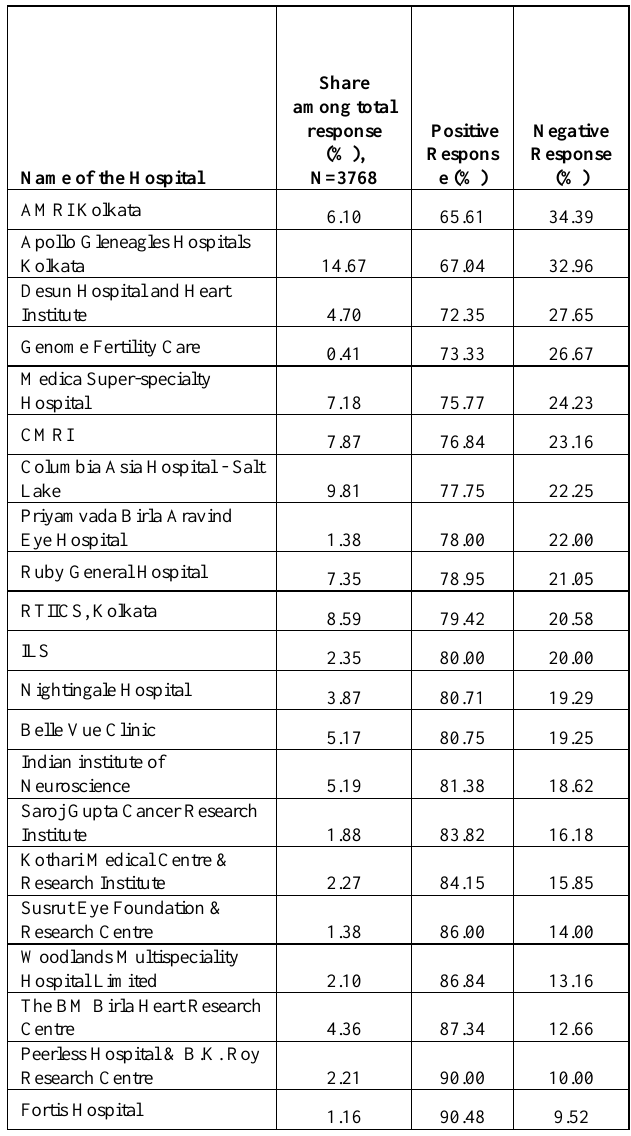
Table 4. Opinion based analysis on the virtual image of